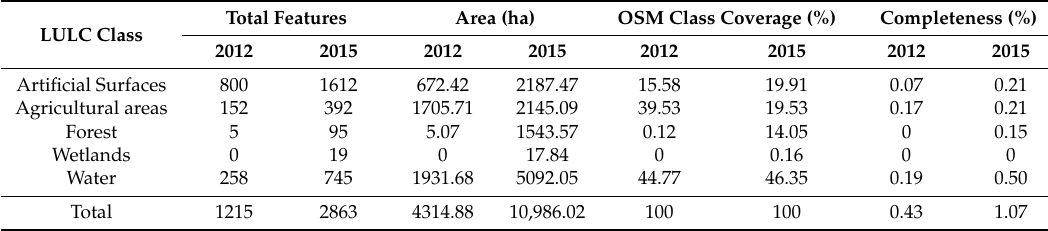
Table 6. Descriptive statistics per class of 2012 and 2015 OSM